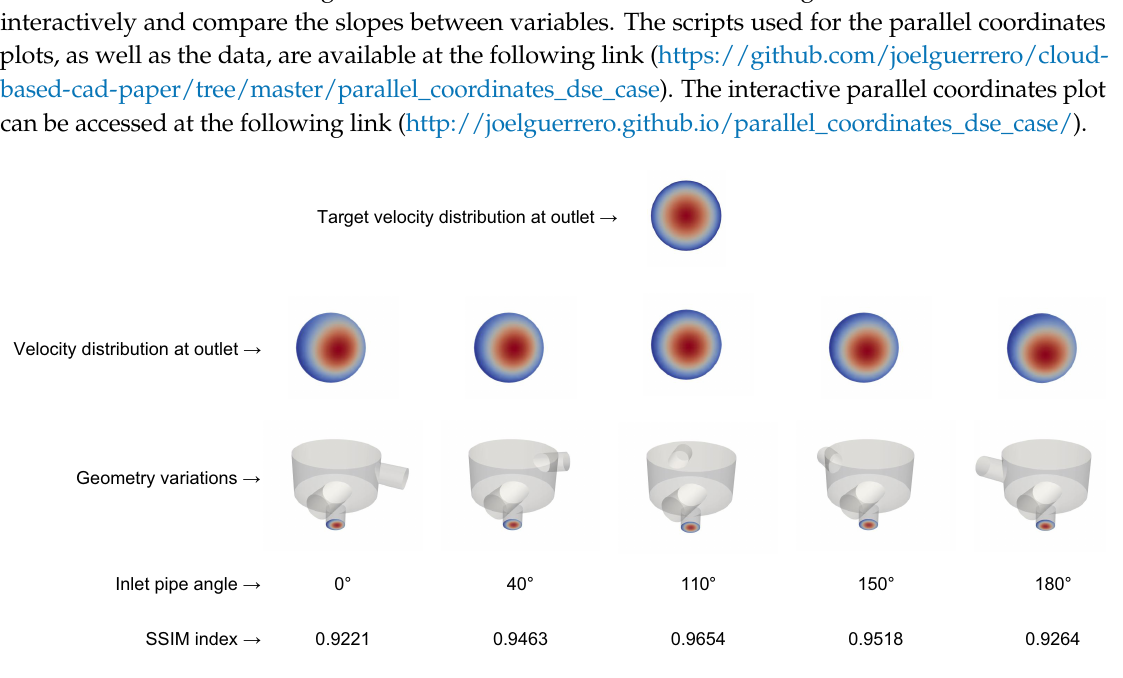
Figure 11. Qualitative comparison of the velocity distribution at the outlet. The SSIM method was used to compare the images. In the SSIM method, a value of 1 means that the images are identical. The target image is shown in the first row of the figure.